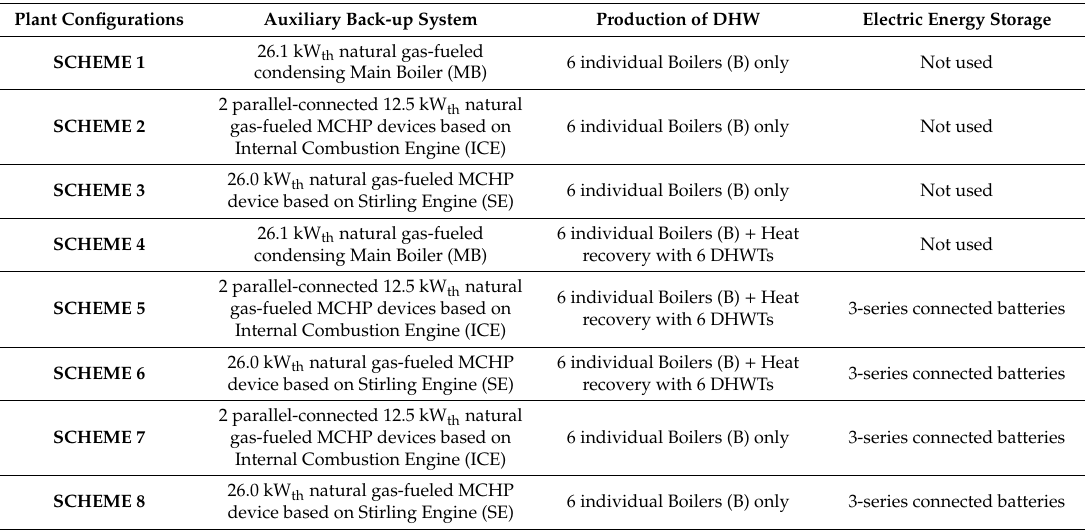
Table 3. Di ff erences between plant schemes upon varying the back-up auxiliary unit, production of DHW and utilization of electric